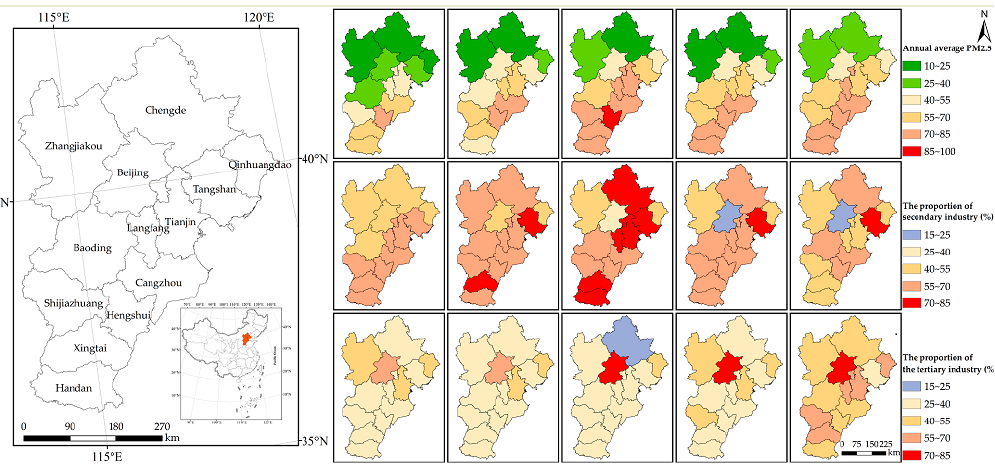
Figure 1. Geographic location, air quality and industrial development status of the Beijing-Tianjin-Hebei region.